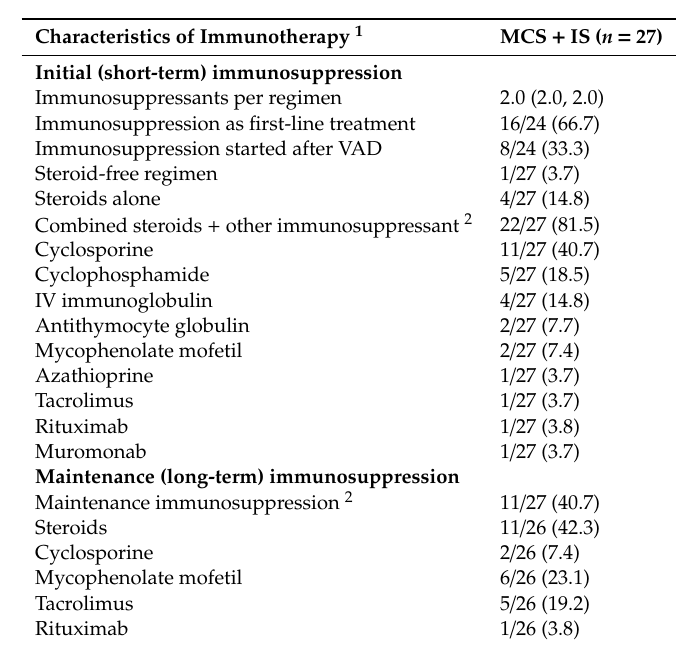
Table 3. Characteristics of immunotherapy associated with short and long-term